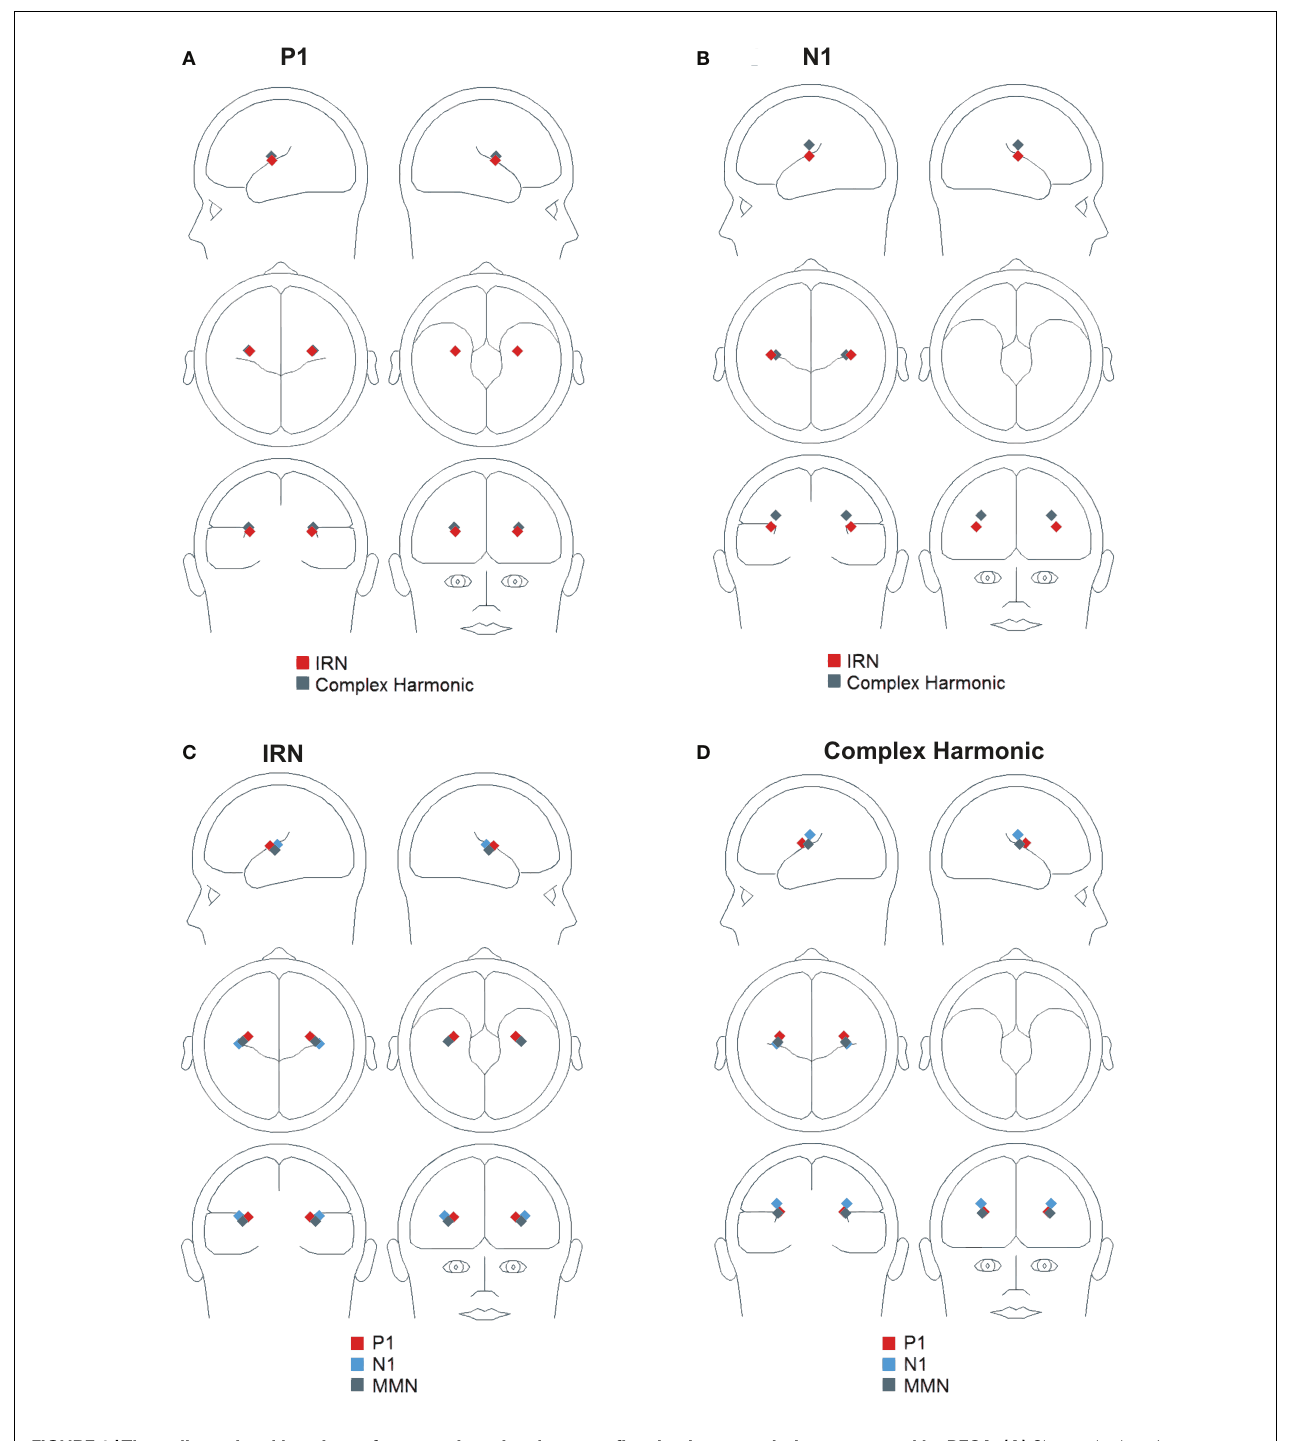
FIGURE 6 |Three-dimensional locations of symmetric regional sources fit using inverse solutions generated by BESA. (A) Shows the location of P1 in both stimulus conditions. (B) Shows the location of N1 in both stimulus conditions. (C,D) Show the location of P1, N1, and MMN in the IRN and complex harmonic conditions,